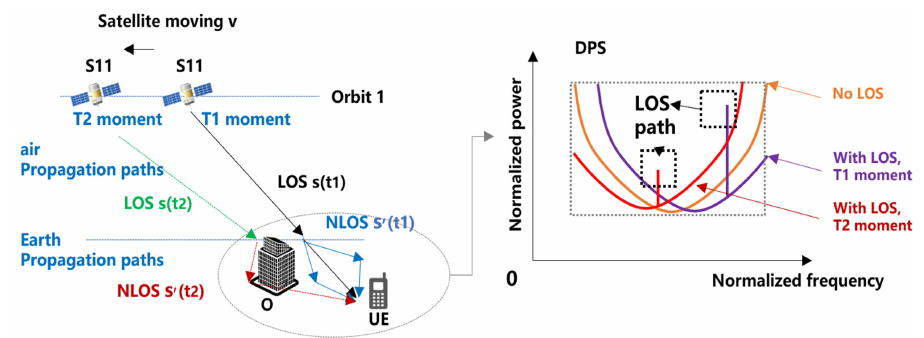
Figure 3. Signal model and DPS model of LEO-SIN.